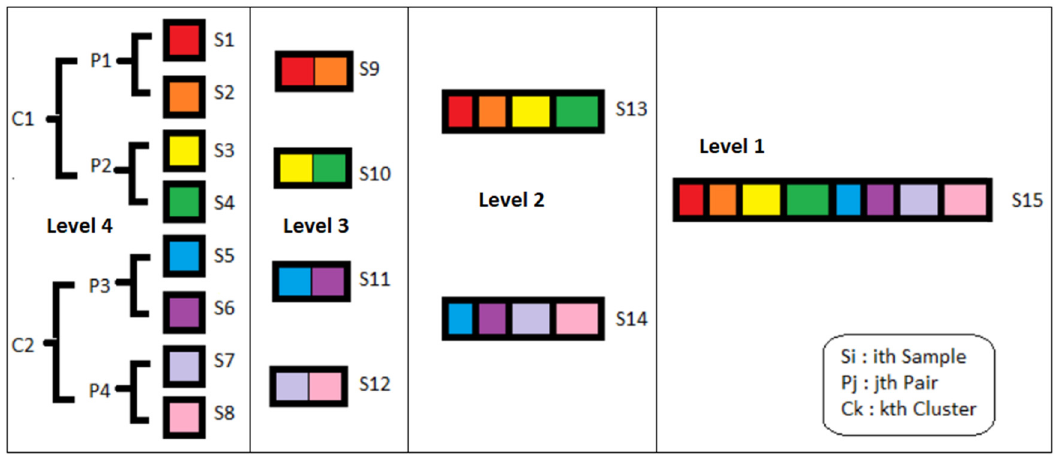
Figure 2: Sample pooling of eight samples in four levels.